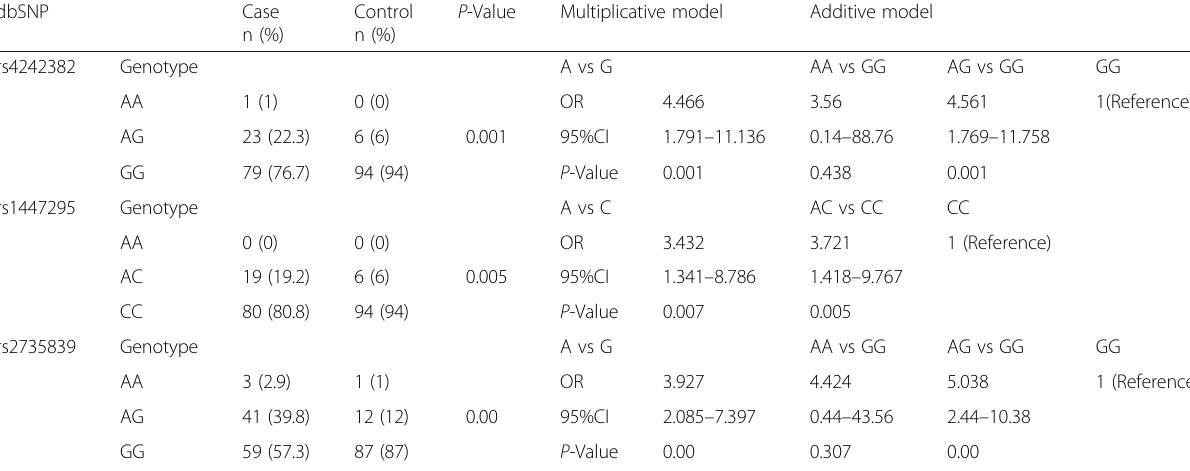
Table 5 Genotype frequency of polymorphisms, multiplicative and additive genetic models dbSNP